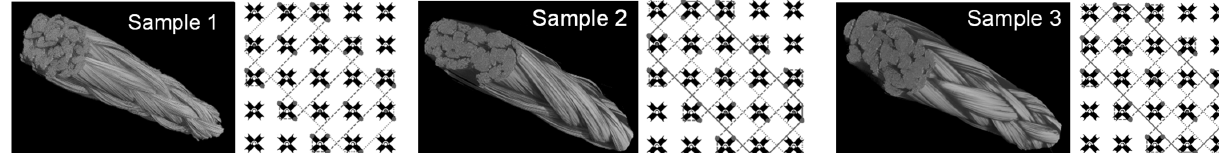
Figure 16. Three-dimensional braided sample 1 ( a ), sample 2 ( b ) and sample 3 ( c ).